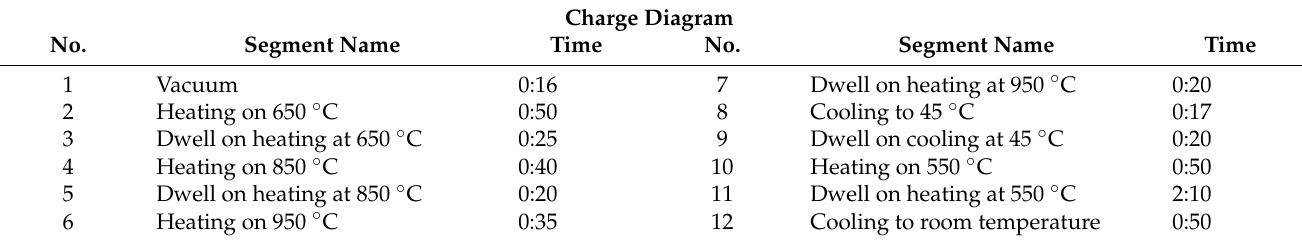
Table 3. Data input for the furnace charge diagram. Charge Diagram